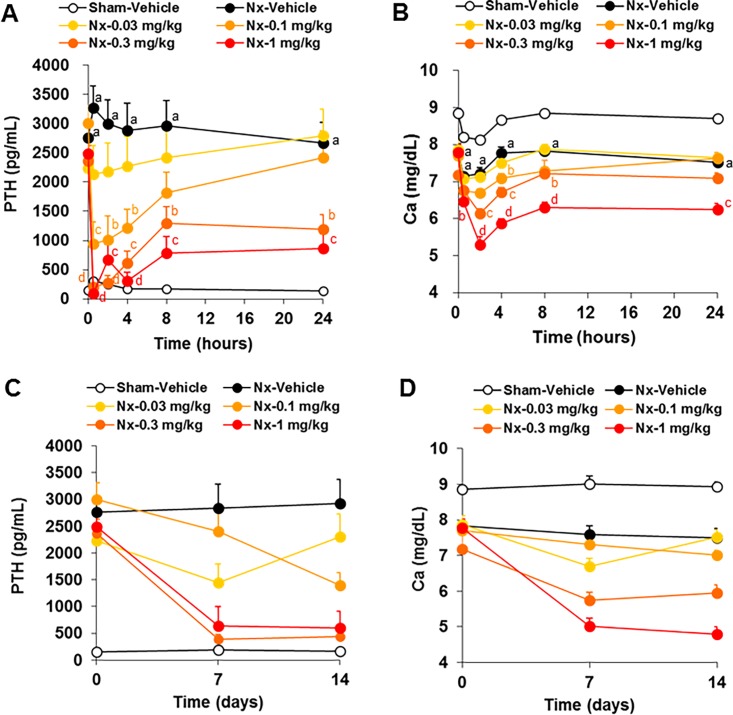
The pharmacological effects of a single and repeated dose of evocalcet in 5/6 Nx rats.Vehicle or evocalcet (0.03, 0.1, 0.3, or 1 mg/kg) was orally administered to sham-operated and 5/6 Nx rats. A and B are the time courses of serum PTH (A) and Ca (B) levels after the first administration. C and D are the serum PTH (C) and Ca (D) levels before (day 0) and 24 h after evocalcet administration (days 7 and 14). The data are presented as the mean + S.E. n = 12/group. aP < 0.001 vs. Sham-vehicle group (Student’s t-test or Aspin-Welch test). bP < 0.05, cP < 0.01, and dP < 0.001 vs. 5/6 Nx-vehicle group (Steel test).